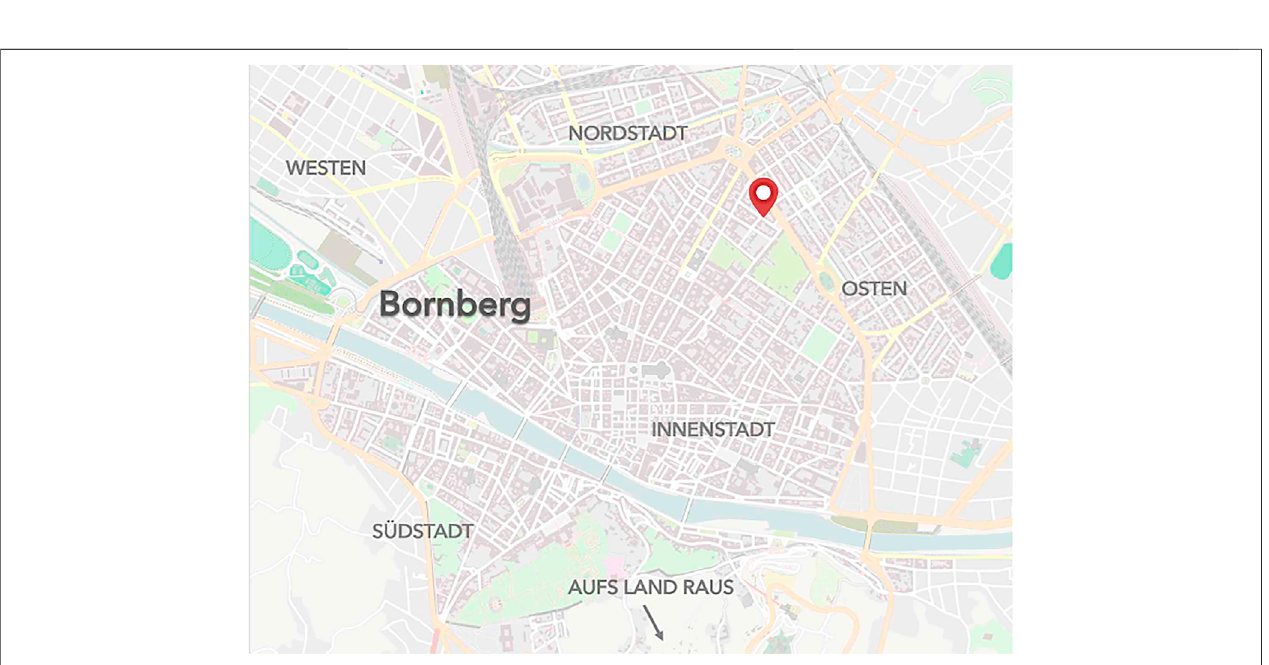
FIGURE 5 | Map of fi ctional city “ Bornberg ” which was embedded into the Graphical User Interface of both participant groups, establishing common ground between them.